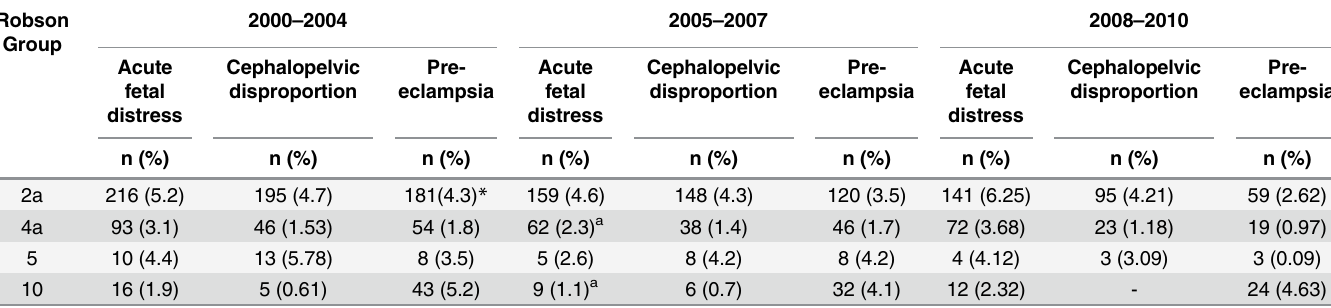
Table 7. Trends in indications for induction in the relevant categories of women in the Robson classification in Peru, 2000 – 2010. Robson